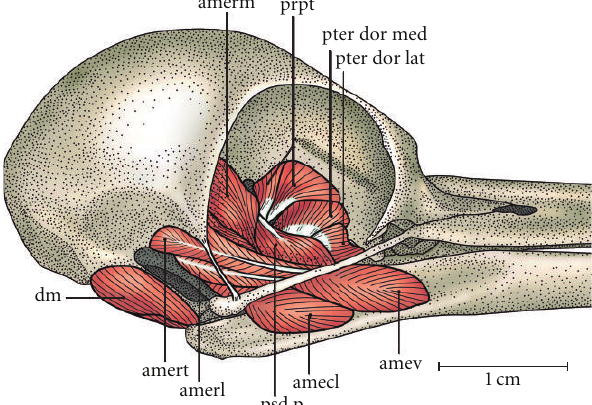
Figure 4: A lateral superficial view of the jaw muscles of Dinopium ra ffl esii. amecl: adductor mandibulae externus caudalis lateralis; amerl: adductor mandibulae externus rostralis lateralis; amerm: adductor mandibulae externus rostralis medialis; amert: adductor mandibulae externus rostralis temporalis; amev: adductor mandibulae externus ventralis; dm: depressor mandibulae; prpt: protractor pterygoidei; psd p: pseudotemporalis profundus; pter dor lat: pterygoideus dorsalis lateralis; pter dor med: pterygoideus dorsalis